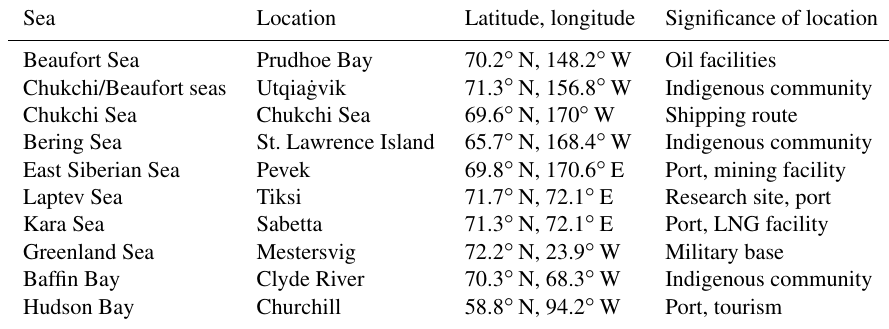
Table 3. Near-coastal locations selected for calculation of breakup and freeze-up